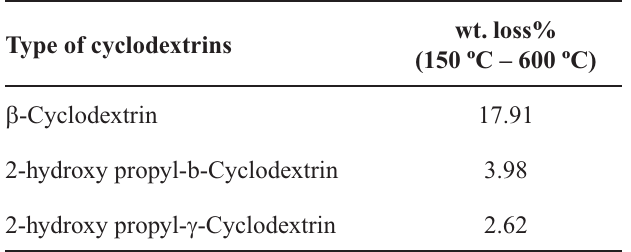
TABLE I - Percentage coating of magnetite nanoparticles with different CD’s